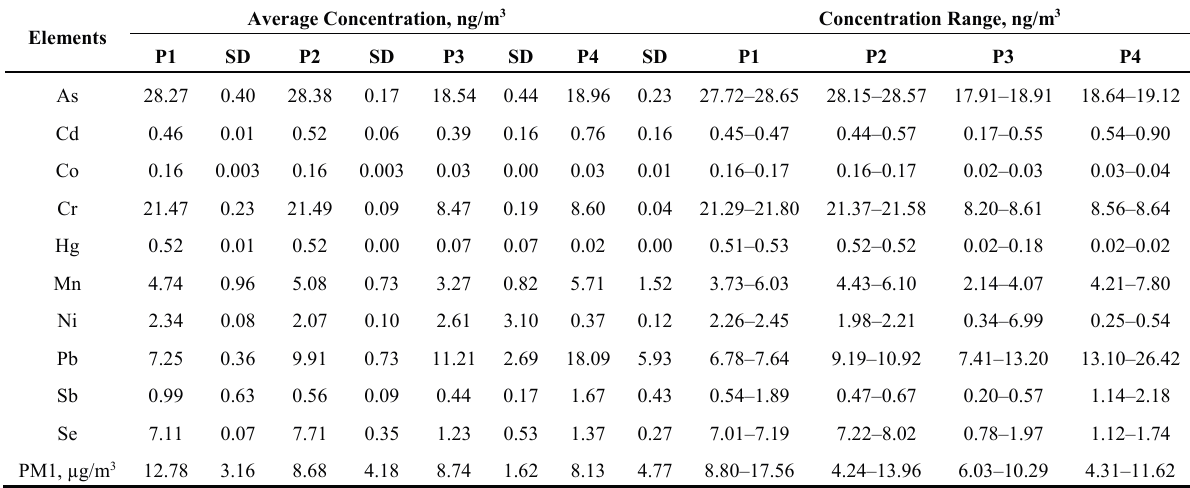
Table 3. The total mass concentration and concentration range of elements at P1–P4